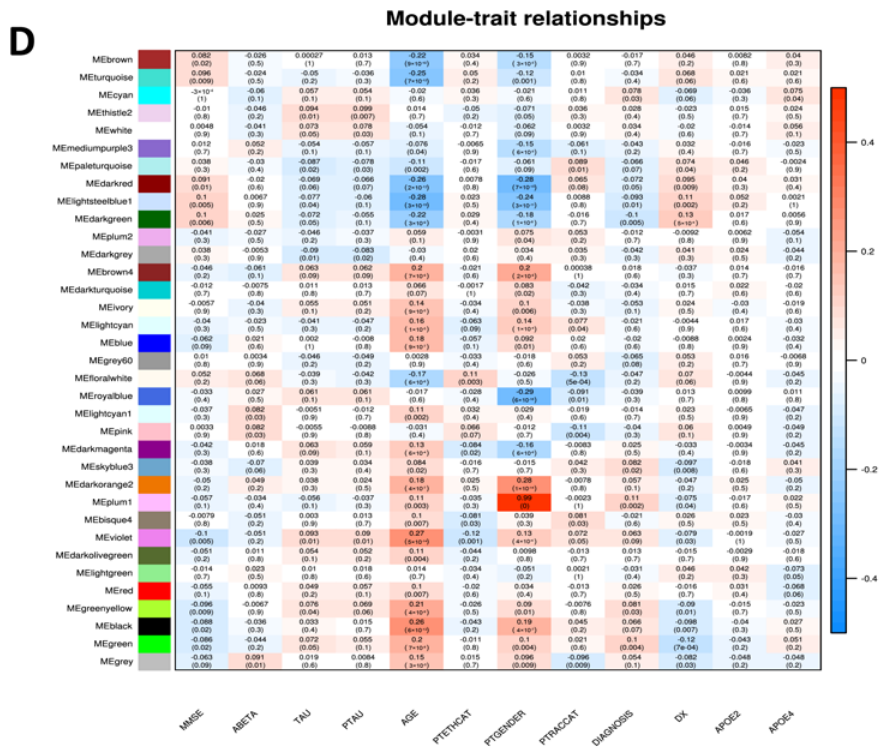
Figure 3. The workflow for WGCNA and identification of key modules. ( A ) Analysis of the scale-free fit index and the mean connectivity for various soft-thresholding powers ( β ). The approximate scale- free topology can be attained at β = 8. ( B ) Cluster analysis of samples to detect outliers. ( C ) Cluster dendrogram: Each color represents one specific co-expression module, and black branches represent genes. ( D ) Heatmaps of the correlation between eigengene and AD-related traits (MMSE, ABETA, TAU, PTAU, AGE, PTETHCAT (ethnicity), PTGENDER (sex), PTRACCAT (race), DIAGNOSIS (CN, MCI, AD), DX (no dementia, AD), APOE2, APOE4). Each row corresponds to a module eigengene, and each column corresponds to a clinical AD trait. Each cell contains the corresponding correlation and p